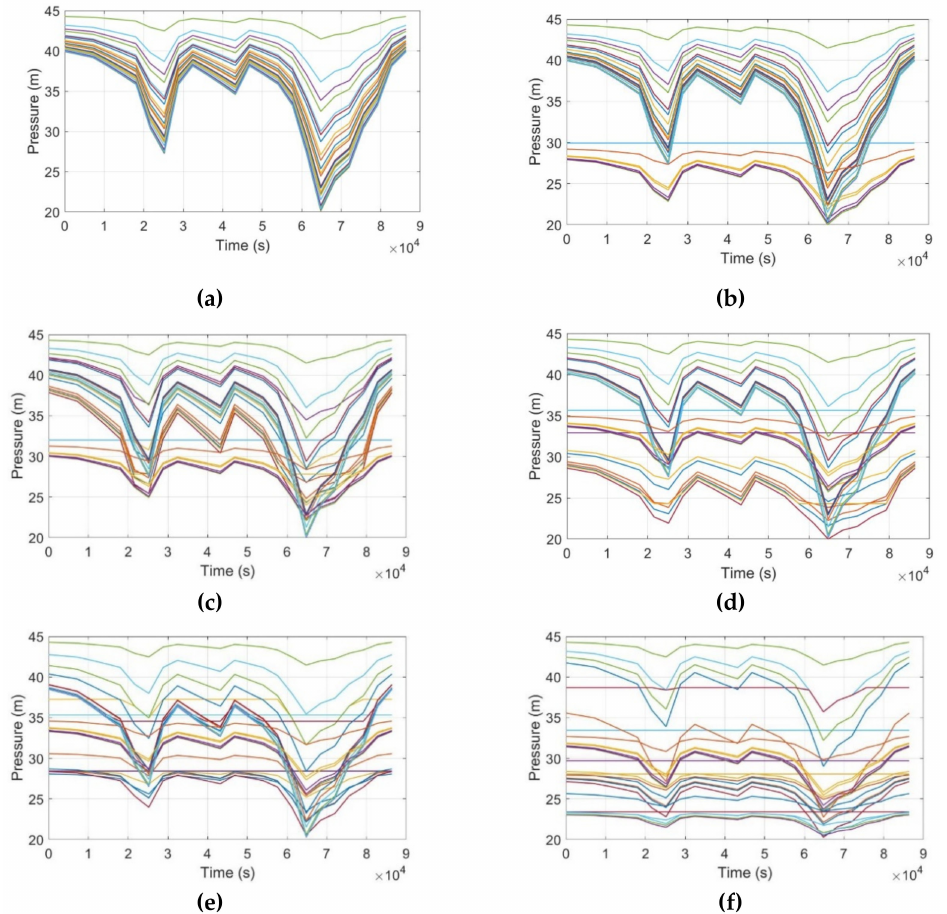
Figure 5. The pressure curves of the Jilin Network. ( a ) The original system; ( b ) with 1 PRV; ( c ) with 2 PRVs; ( d ) with 3 PRVs; ( e ) with 4 PRVs; ( f ) with 5